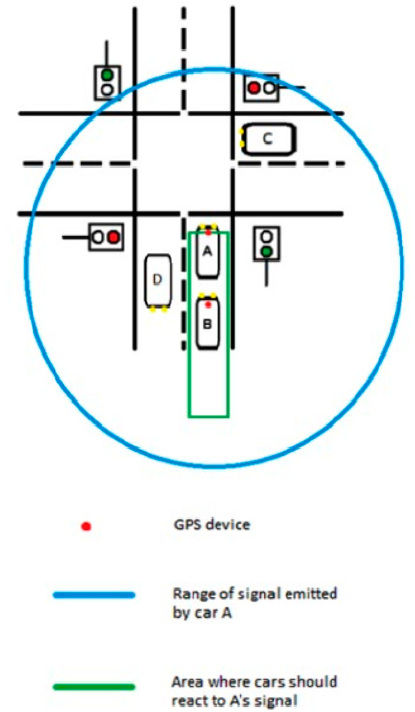
Figure 3. Top view of the simplified situation at the intersection. Range of signals emitted and desirable reaction area to abovementioned signal.